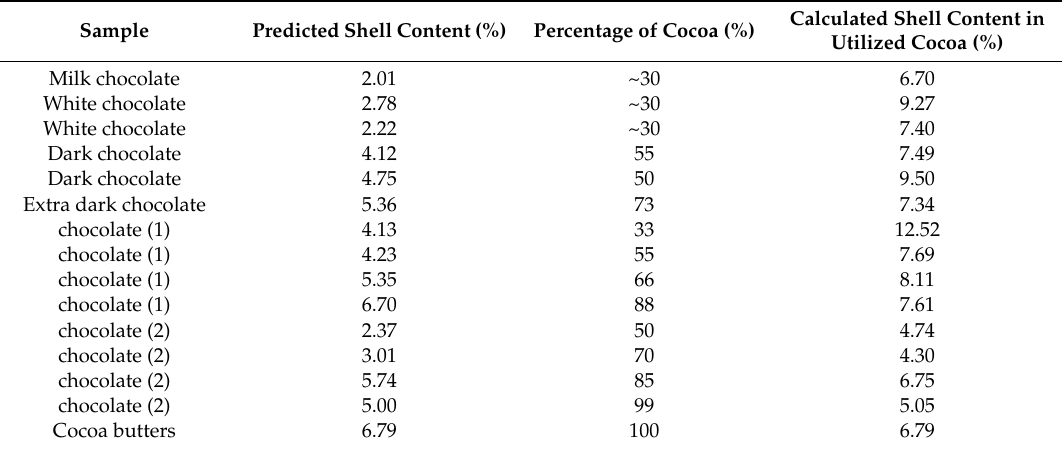
Table 5. Predicted cocoa shell content of di ff erent analysed chocolates and cocoa